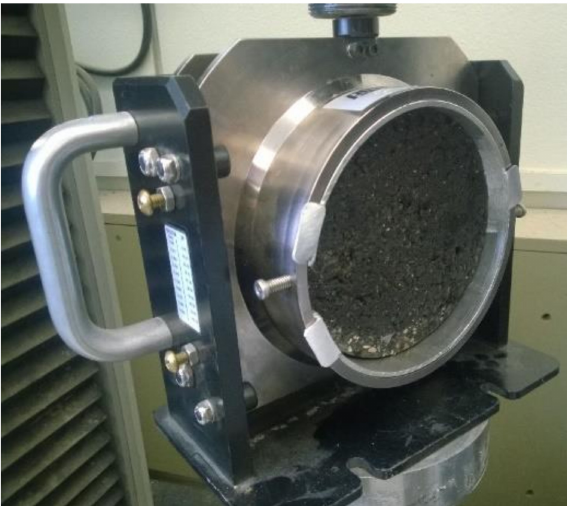
Figure 3. Test apparatus of interface shear